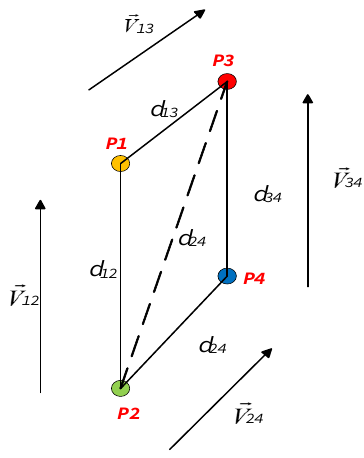
Figure 8. Diagram of 3D to 2D projection.